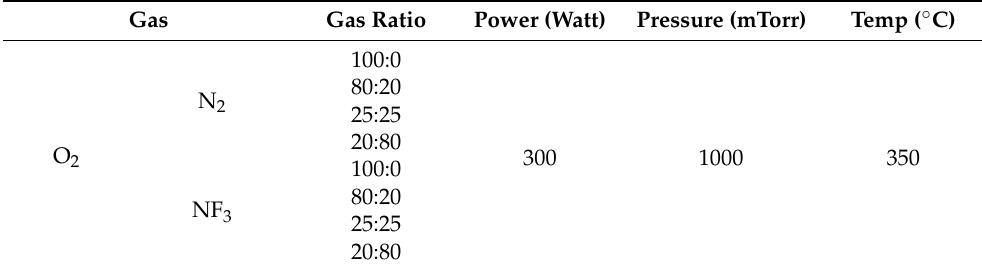
Table 1. Experiment